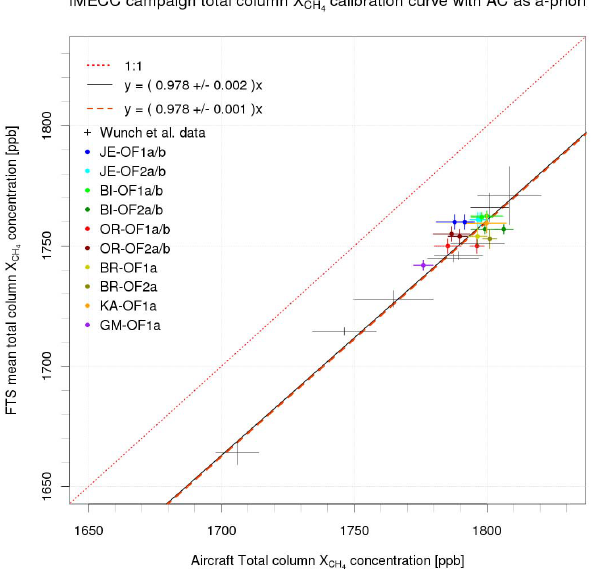
Fig. 6. Calibration factor of CH 4 for all data including Wunch et al. (2010) data derived from the GFIT retrieval with aircraft profiles as a-priori. The black continous line represents the fit for calibra- tion factor ψ aircraft derived for the IMECC data. The dark-orange dashed line represents the fit for calibration factor ψ I + W for all sites (IMECC+Wunch et al.). Both fits are nearly identical.